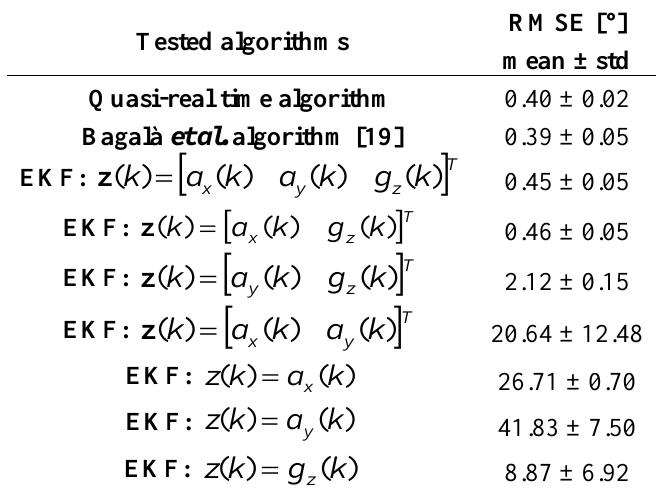
Table 1. Averaged RMSEs for the mechanical